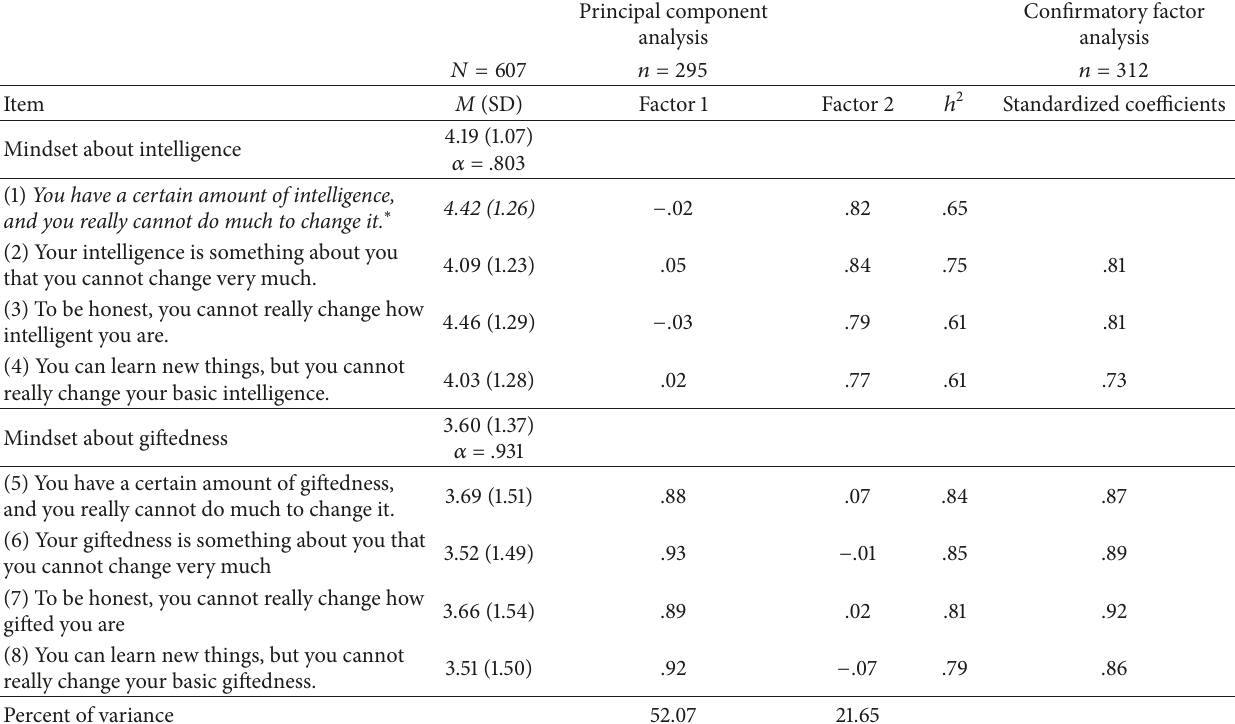
Table 2: Factor loadings, communalities ( h 2 ), and percentages of variance for principal factors extraction and direct oblimin rotation on mindset